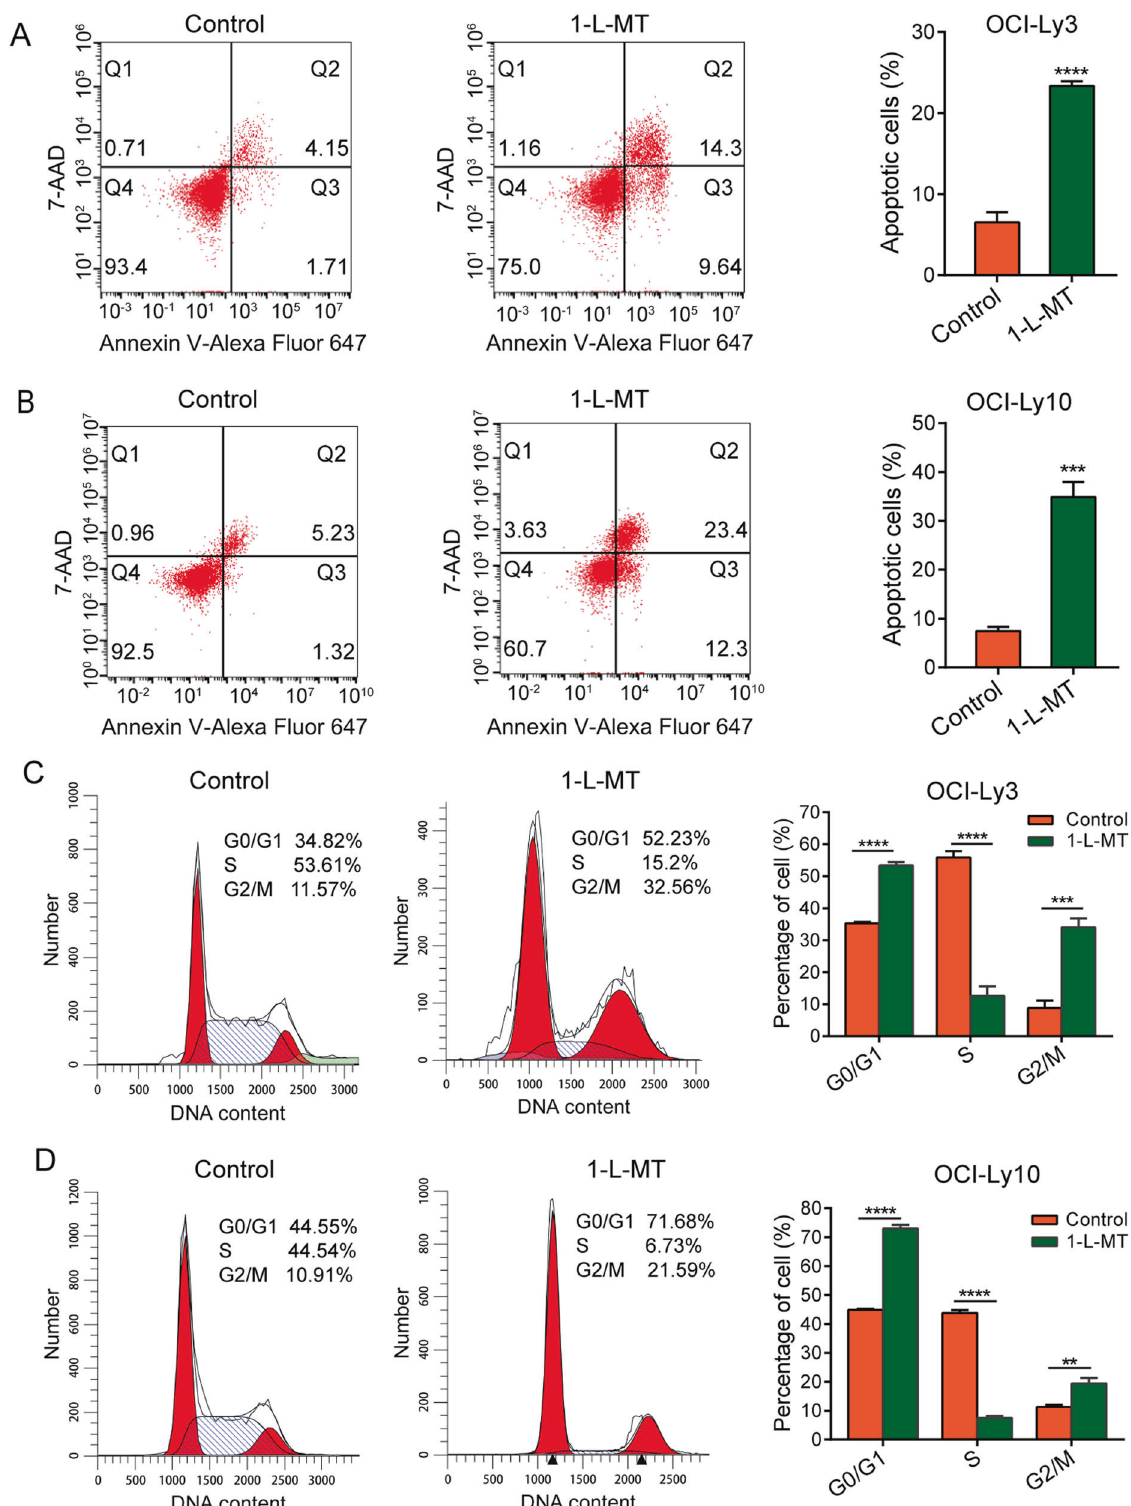
Fig. 4 IDO1 inhibition induced cell apoptosis and G2/M arrest in DLBCL cells. A, B At 48 h after stimulation with 5 mM 1-L-MT, annexin V-Alexa Fluor 647 and 7-AAD staining was performed. Then, the rate of apoptotic cells was analyzed by fl ow cytometry in OCI-Ly3 and OCI- Ly10 cells. C, D OCI-Ly3 and OCI-Ly10 cells were treated with 5 mM 1-L-MT for 24 h. Then, the cell cycle distribution was analyzed using fl ow cytometry. Statistical analysis was analyzed with a two-sided student ’ s t-test. ** P < 0.01, *** P < 0.001 and **** P < 0.0001.